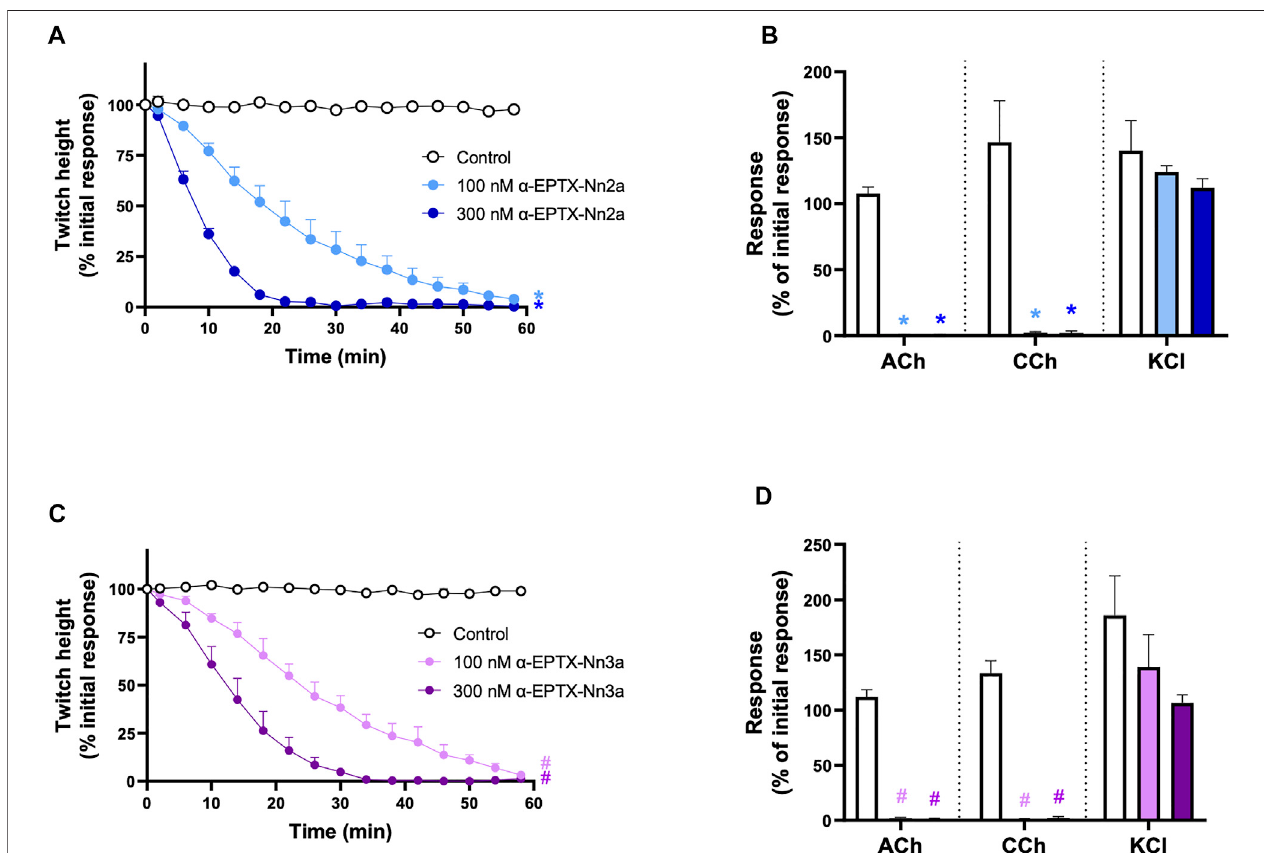
FIGURE 5| The concentration-dependent in vitro neurotoxic effects of; α -Elapitoxin-Nn2a (100 – 300 nm) on (A) indirect twitches and (B) responsesto exogenous agonists ACh (1 mM), CCh (20 µM) and KCl (40 mM); and α -Elapitoxin-Nn3a on (C) indirect twitches and (D) responses to exogenous agonists ACh (1 mM), CCh (20 µM) and KCl (40 mM) in the chick biventer cervicis nerve-muscle preparation. * p < 0.05, signi fi cantly different from (A) control at 60 min (one-way ANOVA; n = 5) or (B) response to same agonist before α -Elapitoxin-Nn2aaddition (paired t -test, n =5). # p < 0.05, signi fi cantly different from (C) control at 60 min (one-way ANOVA; n = 5) or (D) response to same agonist before α -Elapitoxin-Nn3a addition (paired t -test, n =